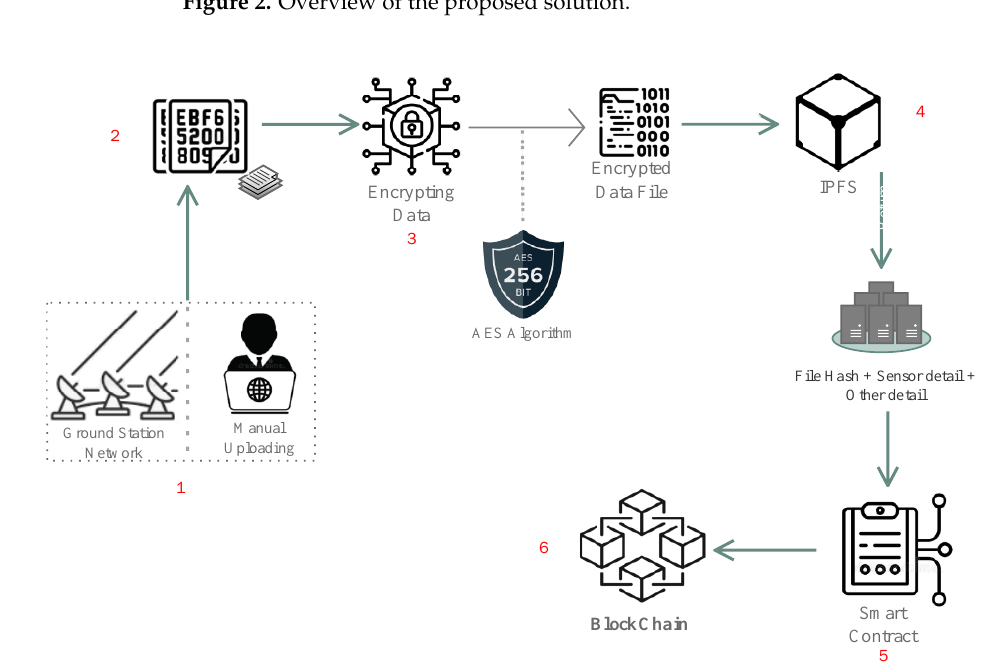
Electronics 2022 , 11 , x FOR PEER REVIEW